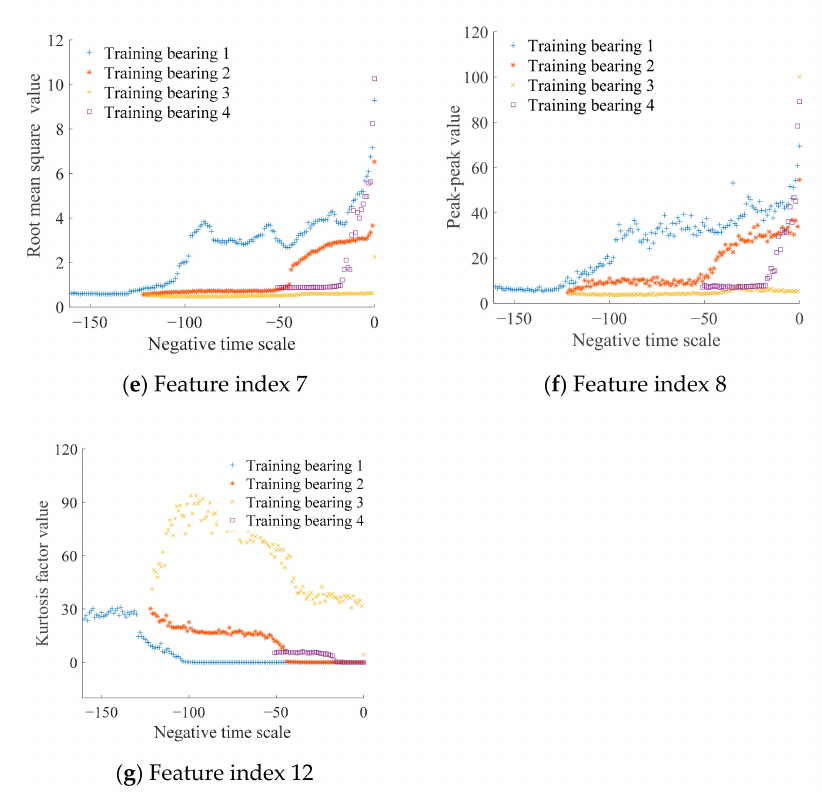
Figure 2. Data trends of selected feature